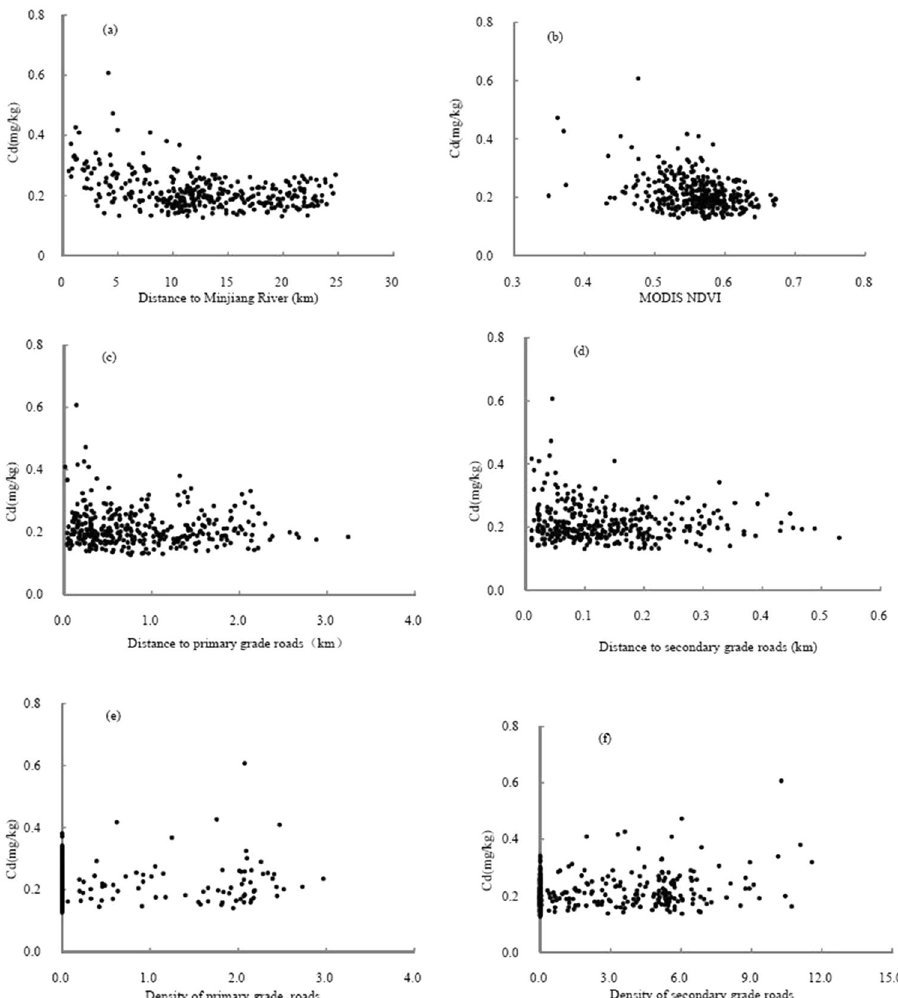
Figure 1. Relationships between soil Cd content and distance to the Minjiang River ( a ), MODIS NDVI ( b ), the distances to primary ( c ) and secondary ( d ) grade roads, and the density of primary ( e ) and secondary ( f ) grade roads.